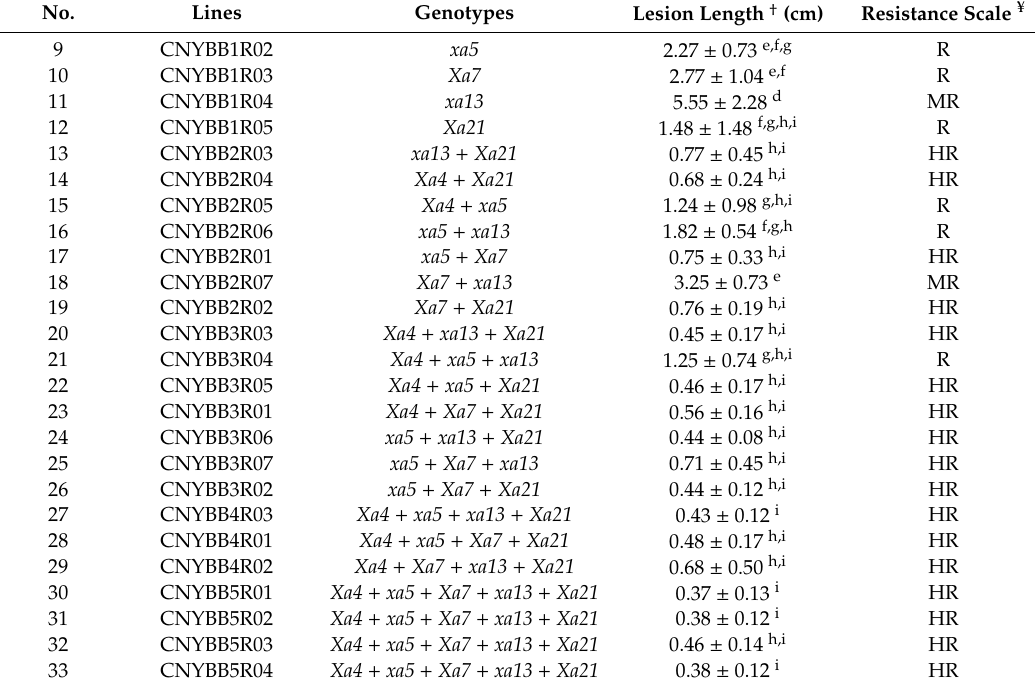
Figure 5. The leaf lesion photo of TNG82/IRBB66 BC 2 F 3 genotypes after 21 days inoculum of bacterial blight pathogen XF89-b in the field at the first crop season in 2016. Susceptible cultivar check: TCS10, IR24, and TN1; Parents: TNG82 and IRBB66. 2.3. Development of BC 3 F 4 Pyramided Lines Using Marker-Assisted Breeding Nine five-gene-pyramided lines at the BC 3 F 4 generation, along with the recurrent and donor parents, were evaluated in the first crop season of 2018 at Taiwan Agricultural Research Institute (TARI), Taiwan. Significant variances were observed between the pyramided lines and parental rice